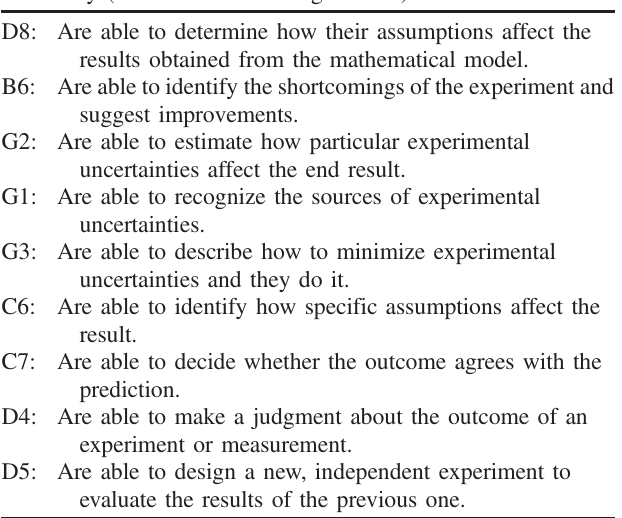
TABLE XI. The subabilities that received low scores on the reports of the prerubrics period. Only subabilities with a median below 2 are included.